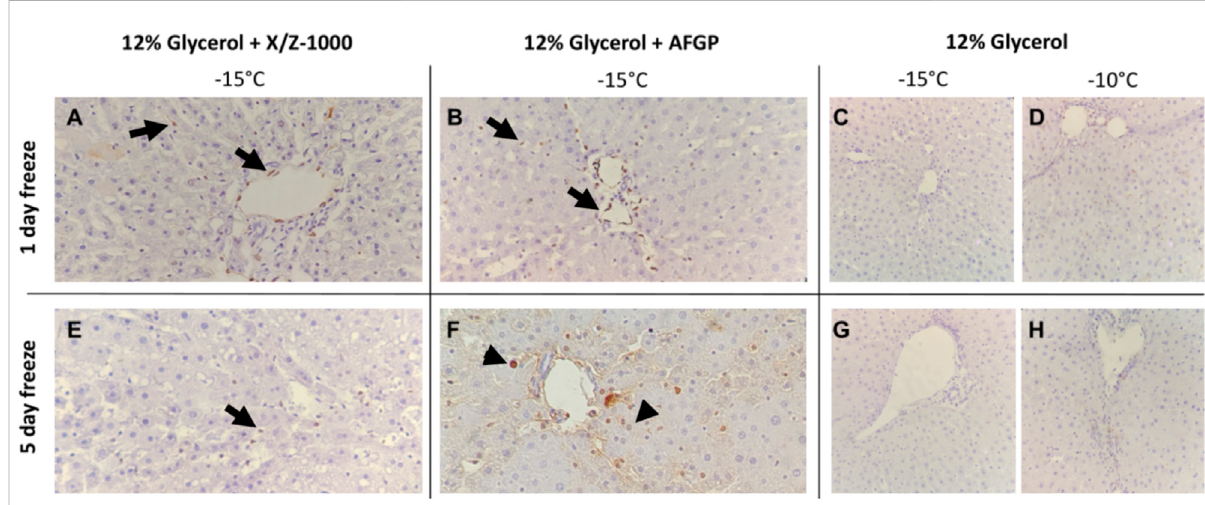
FIGURE 5 TerminaldeoxynucleotidyltransferasedUTPnickend labeling(TUNEL) stainingofratliverparenchymaafter partialfreezing for1 day (A – D) and 5 days (E – H) withX/Z-1000,AFGPicemodulators versus 12%glycerolonly(40X).Blackarrowsindicateendothelialcellstaining.Arrowheadsindicate hepatocyte